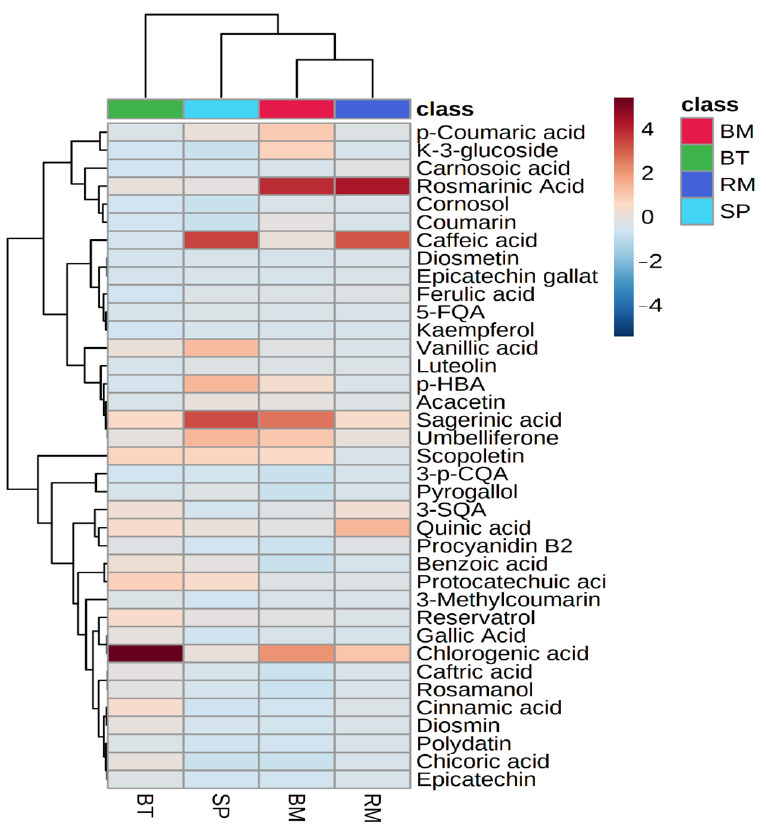
Figure 3. Heatmap clustering of quantified phenolic compounds in bush mint (BM), river mint (RM), bush tomatoes (BT), and sea parsley